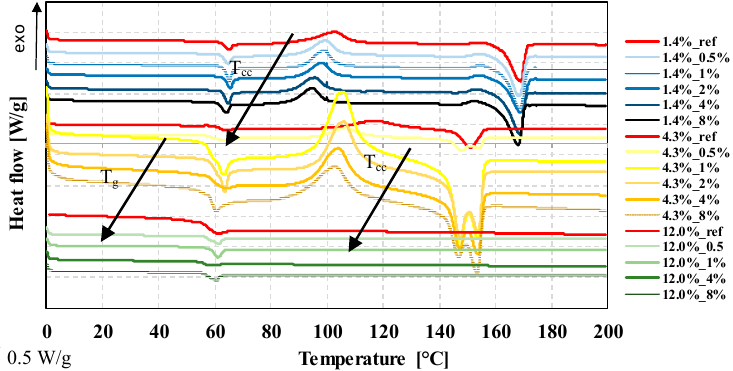
Figure 9. DSC (1st heating) curves of foams produced from three types of PLA with different D -lactide contents, processed at 190 °C.